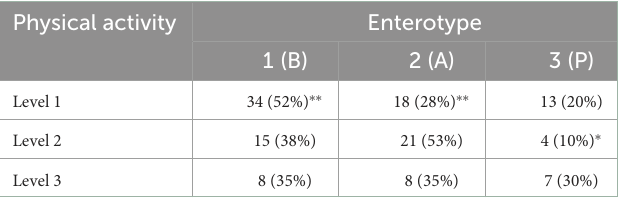
TABLE 2 Enterotype distribution in different physical activity levels in combined groups of esports players and